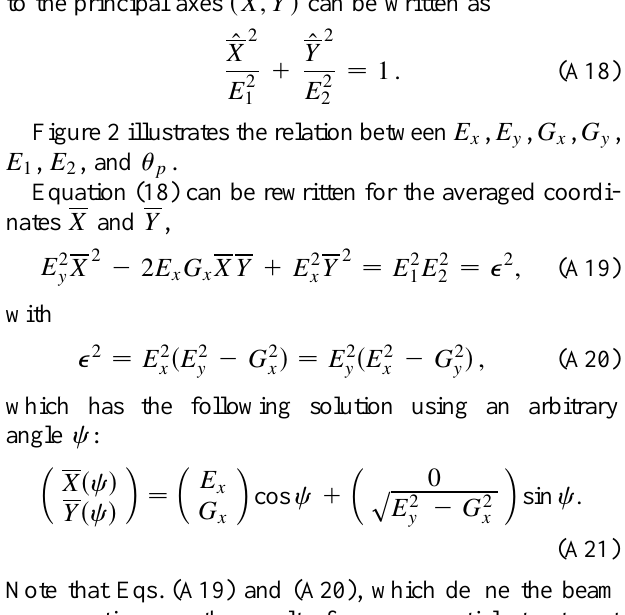
FIG. 2. Cross section of the averaged plane (cid:1) X - Y (cid:2) . i.e., 2p (cid:6) 4 # u p # p (cid:6) 4 . The beam ellipse with respect ˆ ˆ X , Y (cid:2) can be written as to the principal axes (cid:1)